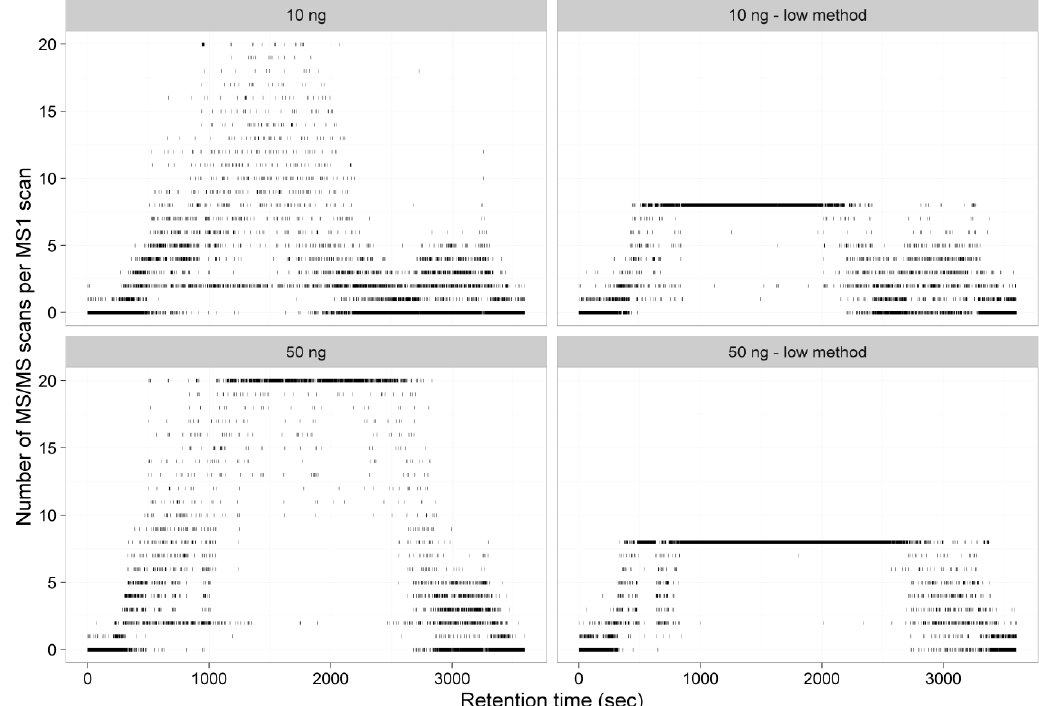
Figure 1. The number of mass spectrometry (MS) / MS scans per MS1 scan in function of the retention time. The samples on the left side are measured using the standard acquisition method. The samples displayed in the righthand panels are measured with the sensitive method, also called the low method.